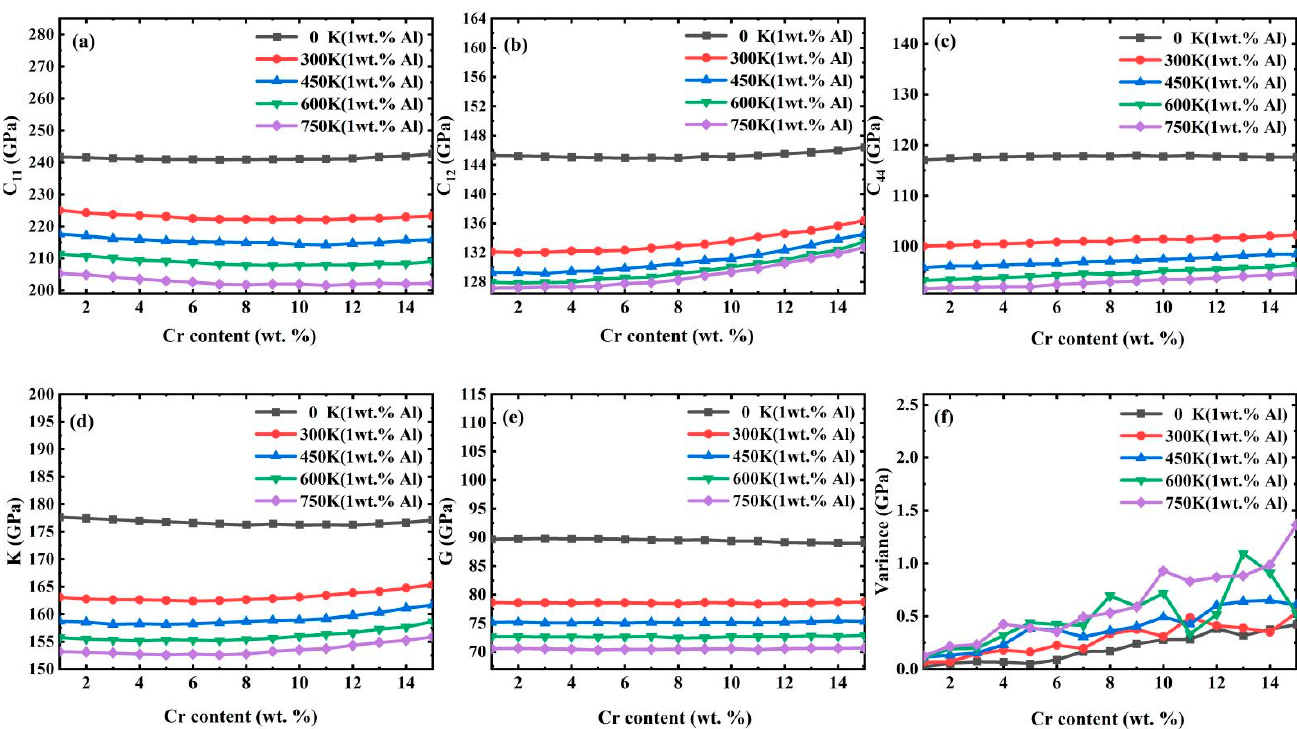
Figure 3. ( a – e ) Dependence of elastic constants, C 11 , C 12 , C 44 , bulk modulus and shear modulus on the concentration of Cr in an FeCrAl alloy with 1 wt.% Al at temperatures 0~750 k, ( f ) example of statistical uncertainty for these elastic constants based on 50 simulations.